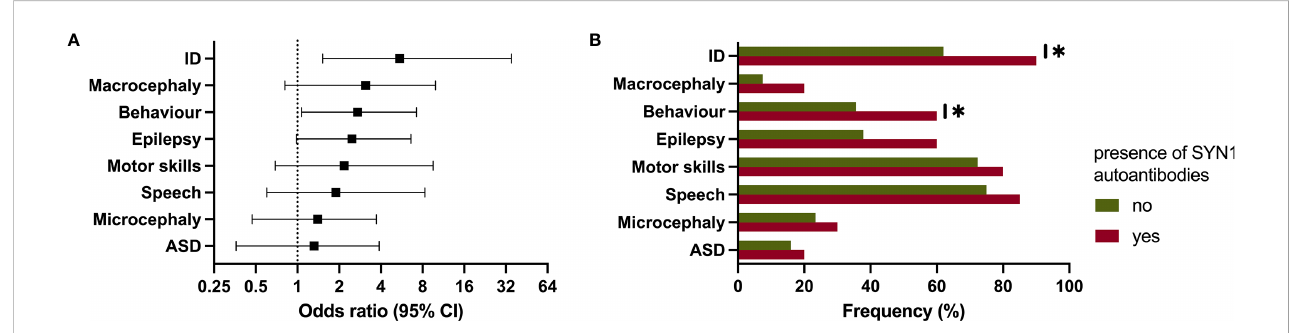
FIGURE 3 Clinical phenotype in patients of mothers with autoantibodies against synapsin 1 (SYN1). (A, B) Forest plot and bar chart showing the signi fi cantly increased risk for intellectual disability and behavioral problems. ID, intellectual disability; ASD, autism-spectrum disorder. * p ≤ 0.05.